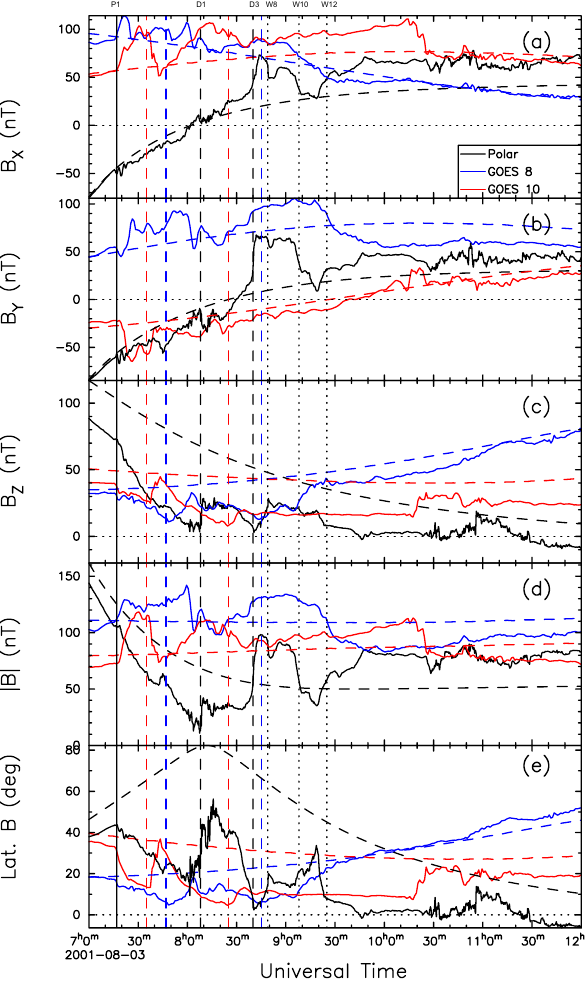
Fig. 7. Stack plot of magnetometer data from GOES 8 (blue) and GOES 10 (red) and Polar (black). Panels (a–c) show the B X , B Y and B Z magnetic field components in GSM coordinates. Panel (d) shows the magnetic field magnitude. Panel (e) shows the angle between the B Z component and the component of the magnetic field in the XY plane (latitude angle). The dashed traces show the output from the T89 magnetic field model in the respec- tive colours of the spacecraft. The horizontal dotted lines indicate zero in each panel. The dashed vertical lines indicate the times of the dipolarizations and the dotted vertical lines indicate the current sheet wave as observed by the various spacecraft and shown in their respective colours. The solid vertical line indicates the effects of the pressure